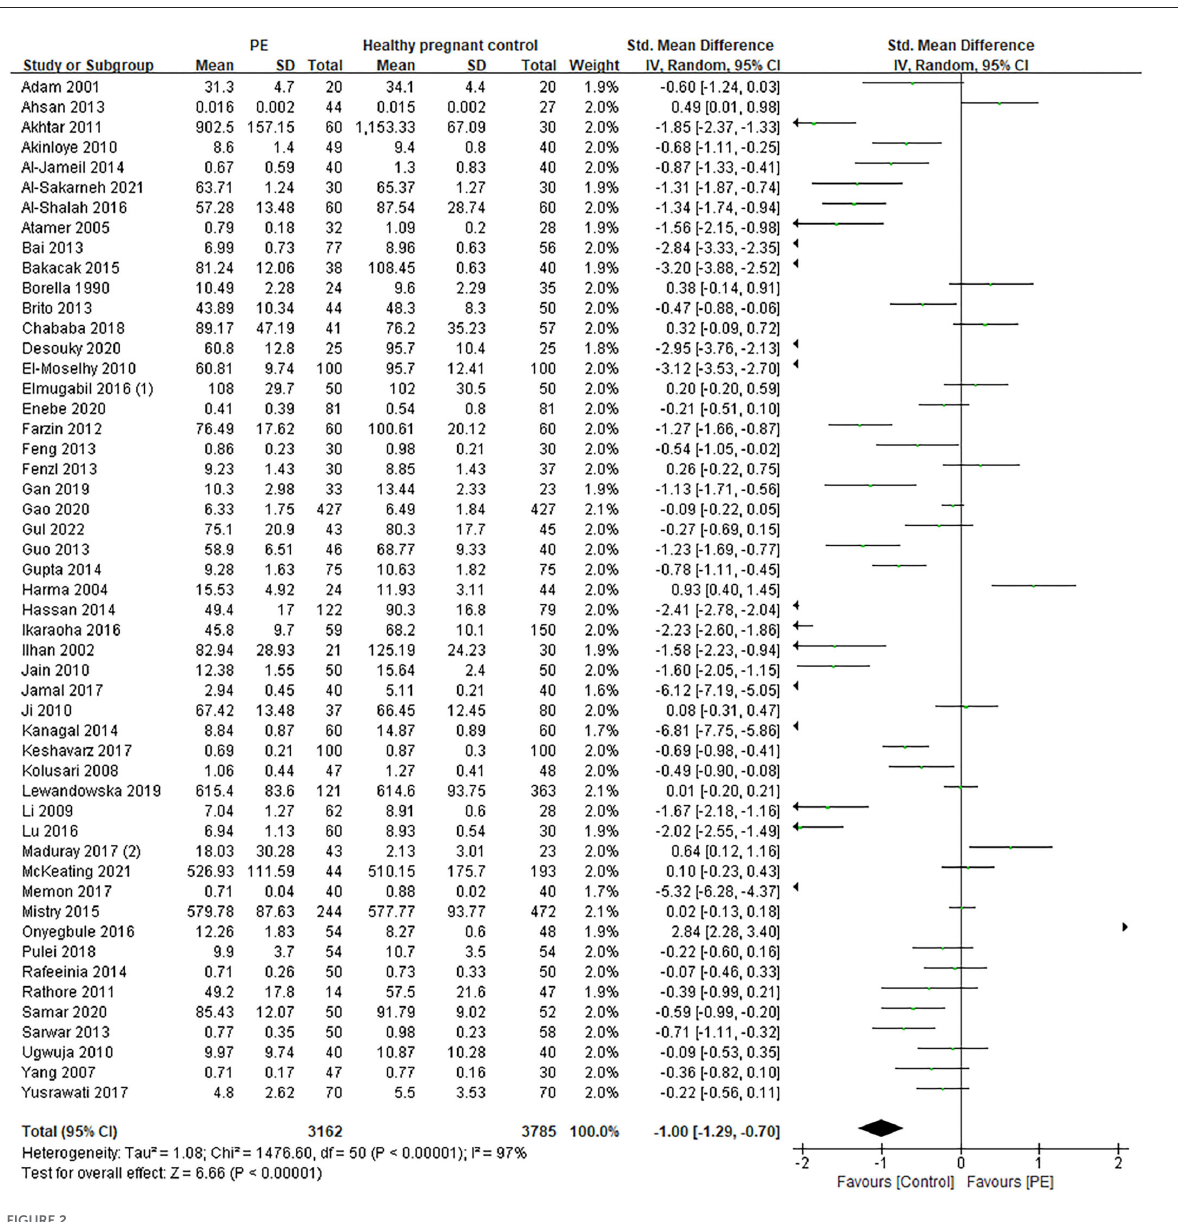
FIGURE2 The forest plot for correlation between maternal serum Zn levels in preeclamptic women and healthy pregnant